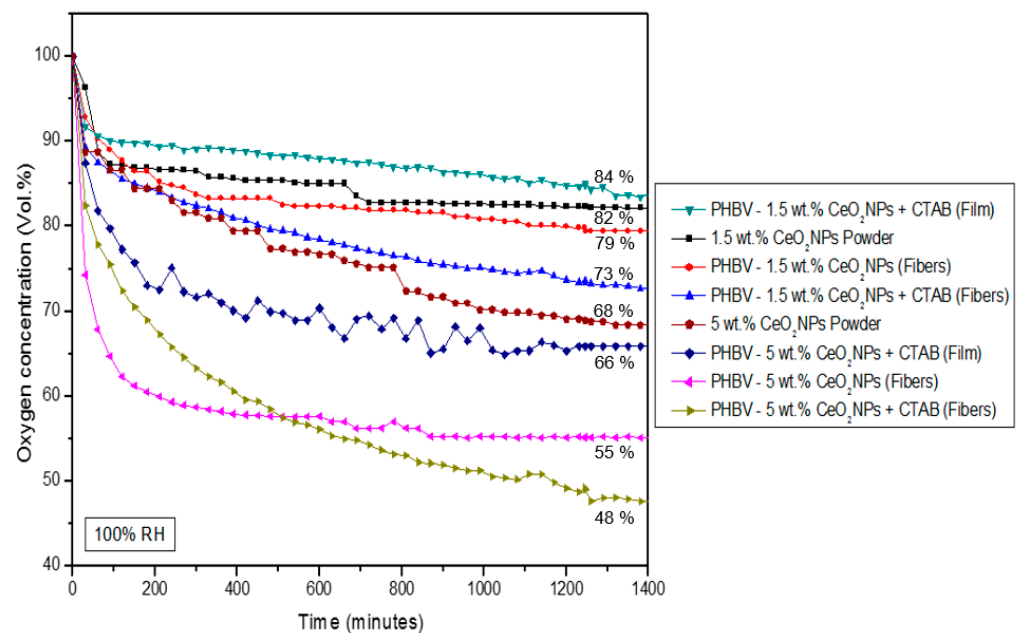
Figure 13. Headspace oxygen volume depletion of cerium oxide nanoparticles (CeO 2 NPs), electrospun poly(3-hydroxybutyrate-co-3-hydroxyvalerate) (PHBV) fibers, and films loaded with 1.5 wt.% and 5.0 wt.% cerium oxide nanoparticles (CeO 2 NPs) with and without hexadecyltrimethylammonium bromide (CTAB). The samples were tested at 100% relative humidity (RH). Table 4. Mechanical characterization of the electrospun poly(3-hydroxybutyrate-co-3- hydroxyvalerate) (PHBV) films loaded with cerium oxide nanoparticles (CeO 2 NPs) and hexade- cyltrimethylammonium bromide (CTAB) based on tensile modulus (E), tensile strength at yield ( σ y ), elongation at break ( ε b ), and toughness